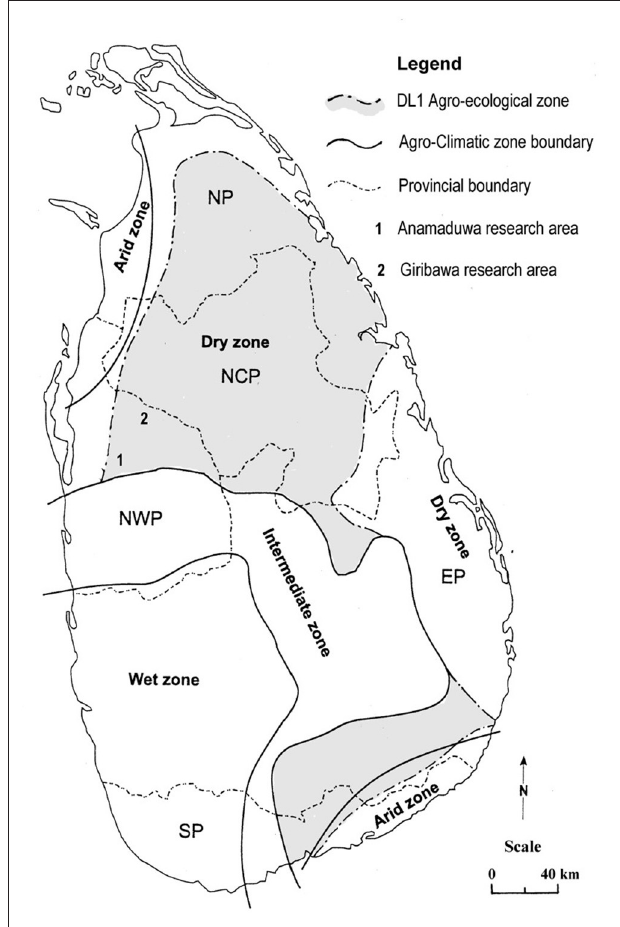
FIGURE 1 | Location of research clusters in Norwest Province (NWP), Sri